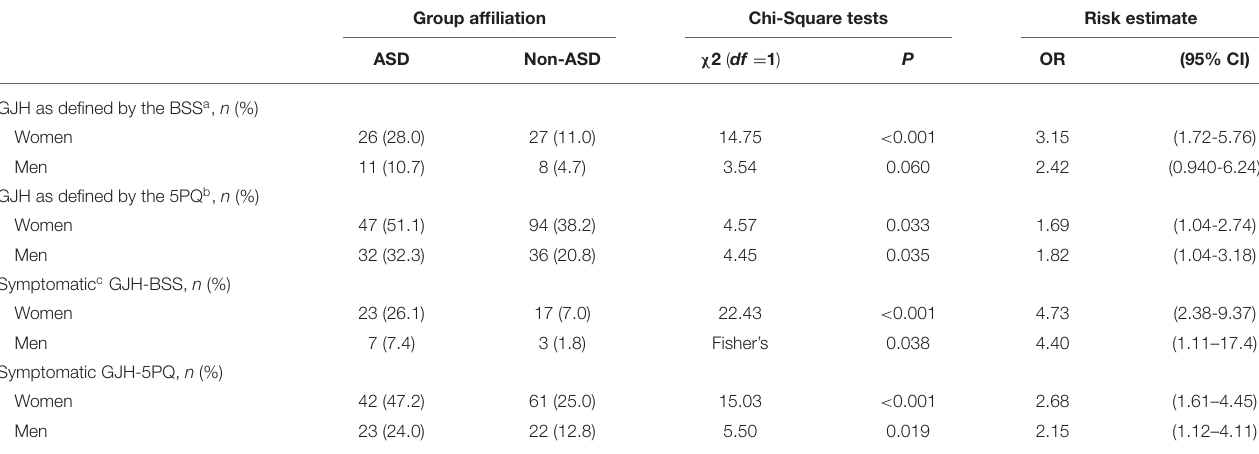
TABLE 2 | Prevalence of generalised joint hypermobility and symptomatic generalised joint hypermobility. Group affiliation Chi-Square